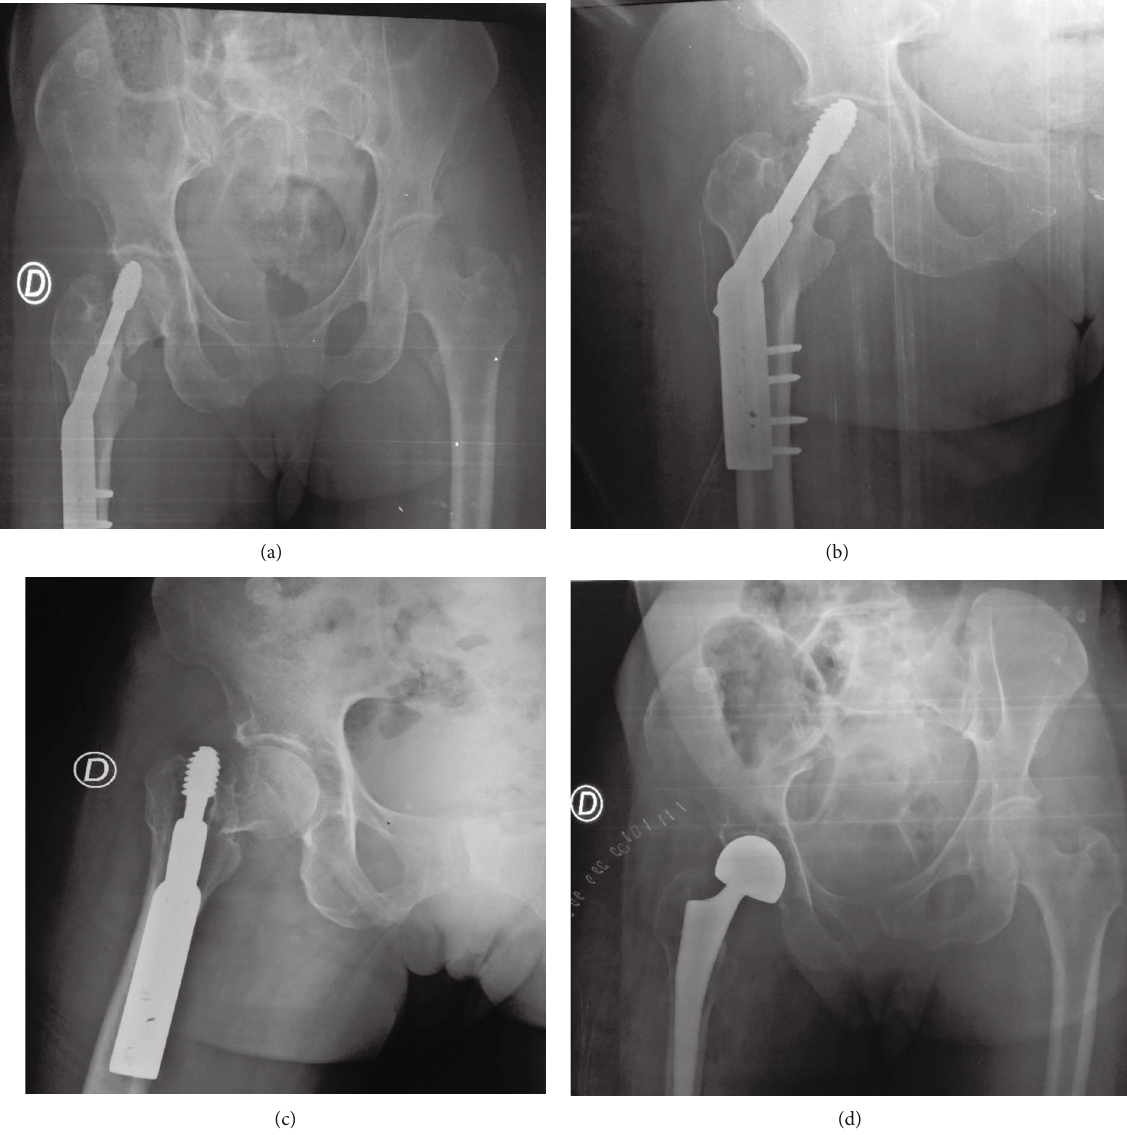
Figure 2: X-rays of patient 2. (a) DHS osteosynthesis of neck fracture. (b) Neck pseudarthrosis with phenomenon. (c) Cut out phenomenon with cephalic osteonecrosis. (d) Right